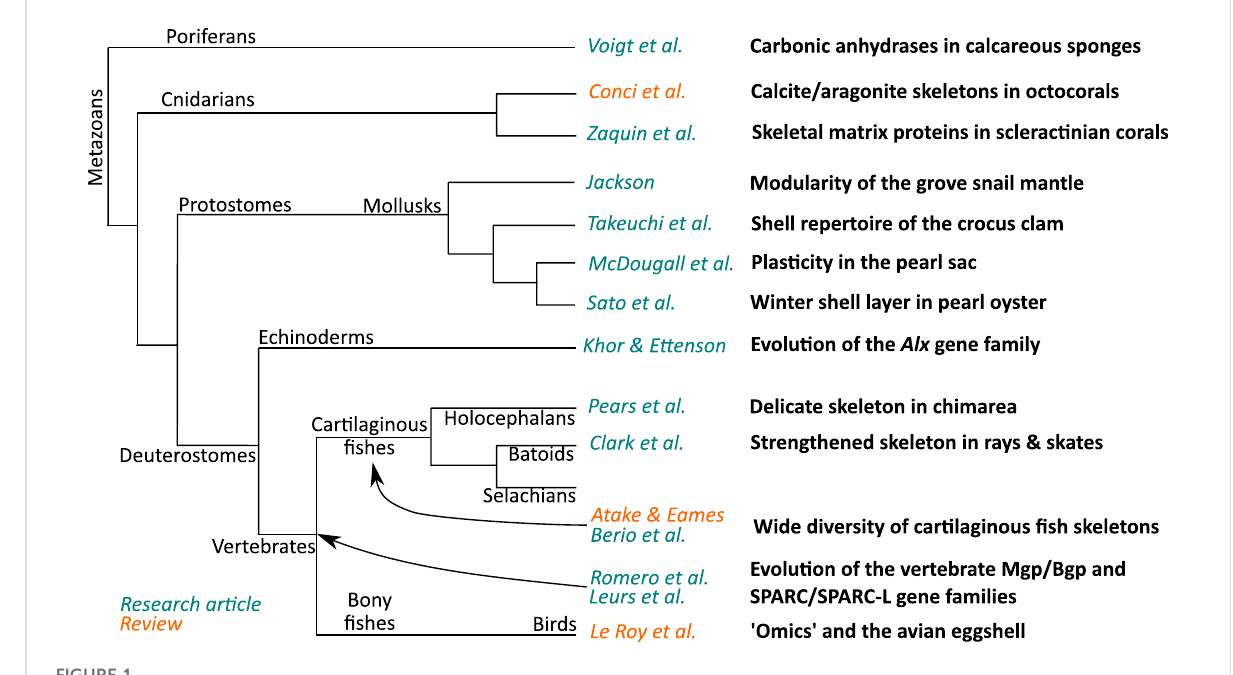
FIGURE 1 The phylogenetic relationships of the 15 contributions of this Research